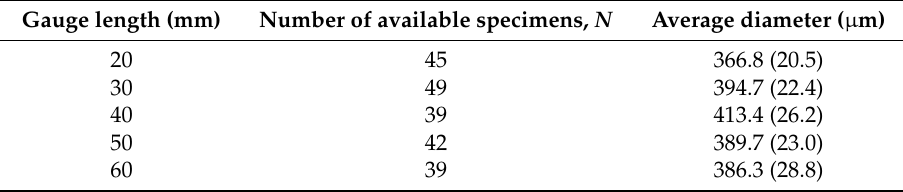
Values in parenthesis denote the standard